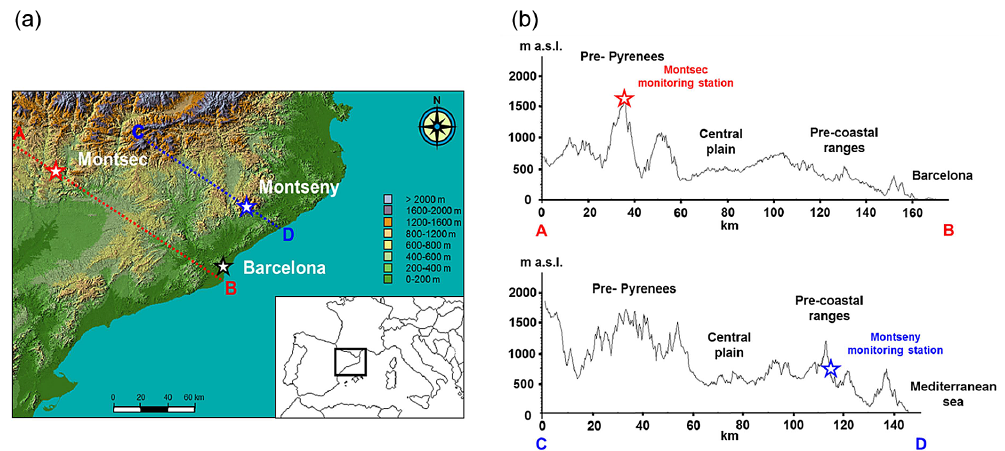
Figure 1. (a) Location of Montsec (MSA; remote mountain-top) and Montseny (MSY, regional background) measurement sites. (b) Topo- graphic profile of MSA and MSY